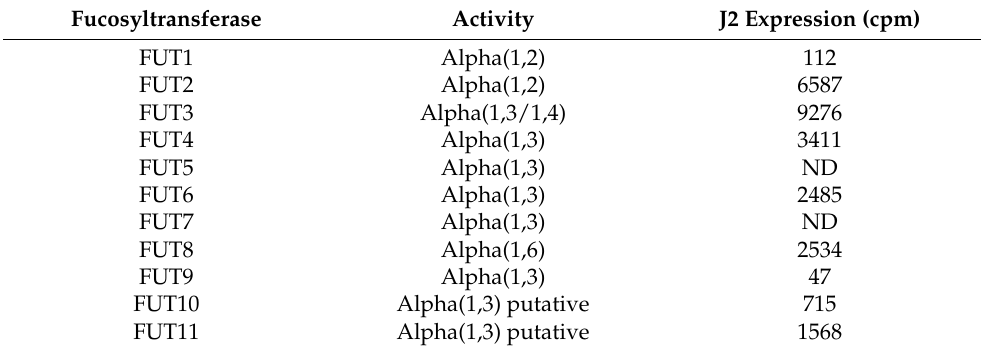
Figure 4. FUT2 is necessary for α 1, 2-fucose expression on the apical surface. Previously unpublished images. HBGA expression was analyzed by UEA-1 lectin (red) in HIE lines as described in [48]. In all image panels, the nuclei are marked with DAPI (blue). In the bottom panels, the brush border is indicated by actin expression using phalloidin (white) for each line. Table 4. Expression of fucosyltransferases in J2 HIEs.